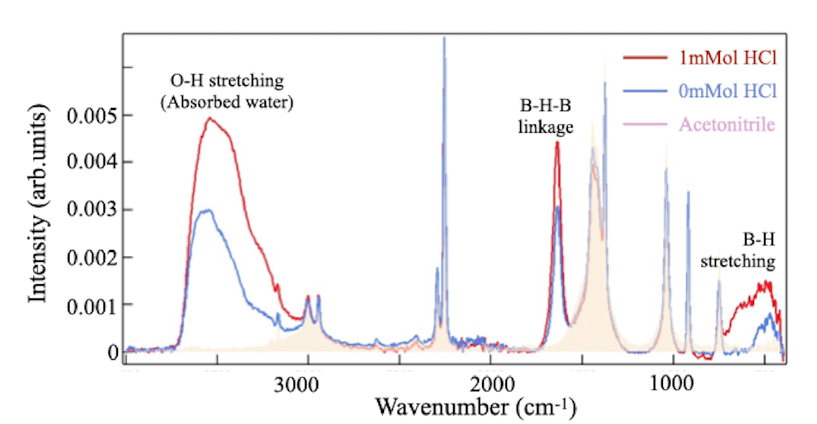
Figure 5. Comparison of the FT-IRAS spectra from the sample filtrate synthesized with (red curve) and without (blue curve) 1 mL of hydrochloric acid. For reference, the spectrum of the acetonitrile solvent (yellow shadow) is